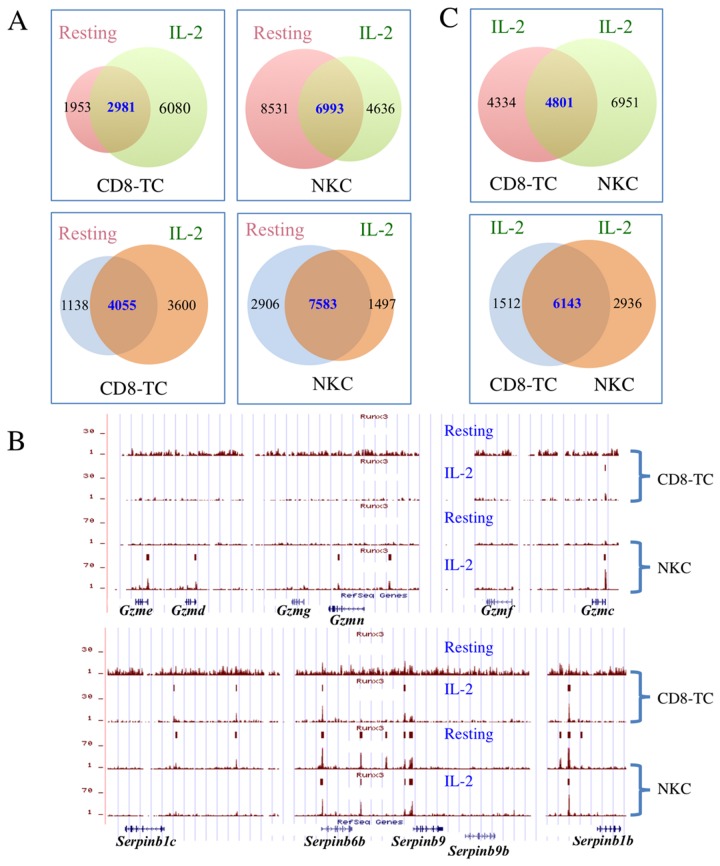
Runx3-bound regions and their corresponding annotated genes in IL-2-activated compared to resting CD8-TC and NKC.(A) Overlap of Runx3-bound (upper panels) regions or their corresponding genes (lower panels) in resting and IL-2-activated CD8-TC (left) or NKC (right). The genes corresponding to Runx3-bound regions were derived using GREAT [19]. (B) Recruitment of Runx3 to de novo IL-2-activated regions in Gzme-Gzmc (top) and Serpinb1c-Serpinb1b (bottom) loci, in NKC and CD8-TC, respectively. Brown tracing and rectangles represent Runx3 ChIP-seq wiggle files and the positions of Runx3 peaks, respectively, as in Figure 1. Note that some de novo Runx3-bound regions in Serpin genes in IL-2-activated CD8-TC appear to bind Runx3 in resting CD8-TC, but these regions are not scored by MACS as peaks in resting CD8-TC due to the higher background. (C) Overlap of Runx3-bound regions (upper panel) and their corresponding genes (lower panel) in IL-2-activated CD8-TC and NKC.